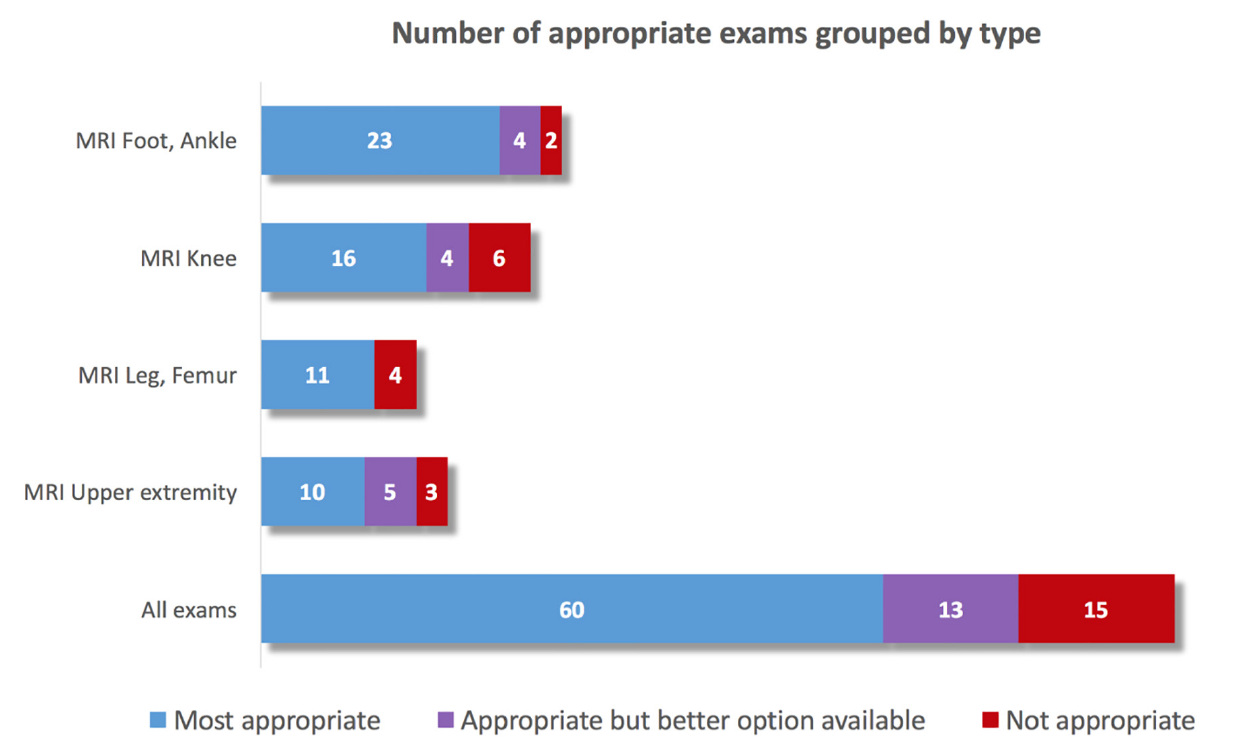
Figure 2. Distribution of magnetic resonance imaging (MRI) appropriateness by body